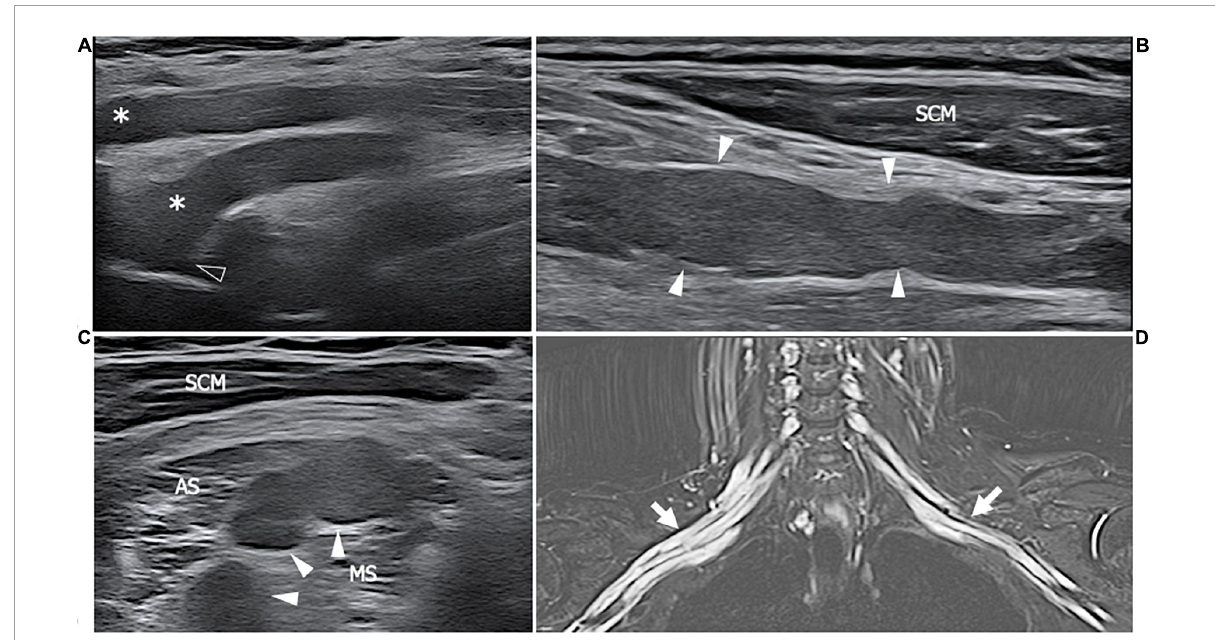
FIGURE6 This figure shows three 18 MHz HRUS images (A–C) and a T2-weighted with fat-suppression magnetic resonance image (D) of a 50 years old female affected by SS who developed a predominant-upper limb sensory-motor demyelinating neuropathy. (A) A long-axis view of brachial plexus roots (white asterisk) at the exit from the intervertebral foramens (empty arrowhead) is obtained: the massive hypoechoic enlargement of the nerves with the complete loss of the typical fascicular echotexture is observed; these findings extend also more distally at the level brachial plexus trunks and divisions as seen in (B) . Also in the latter, the long axis view depicts the irregular profile of the nerves (white arrowheads), with areas of thinning and area of nerve enlargement, findings which are typical of a CIDP neuropathy. (C) A short axis view of the pathological nerve trunks (white arrows) in the interscalenic space is shown. (D) The MR coronal view of the neck and upper thorax demonstrates a massive, irregular enlargement of the brachial plexus bilaterally (white arrows); the increased T2-signal of the brachial plexus roots, trunks, divisions